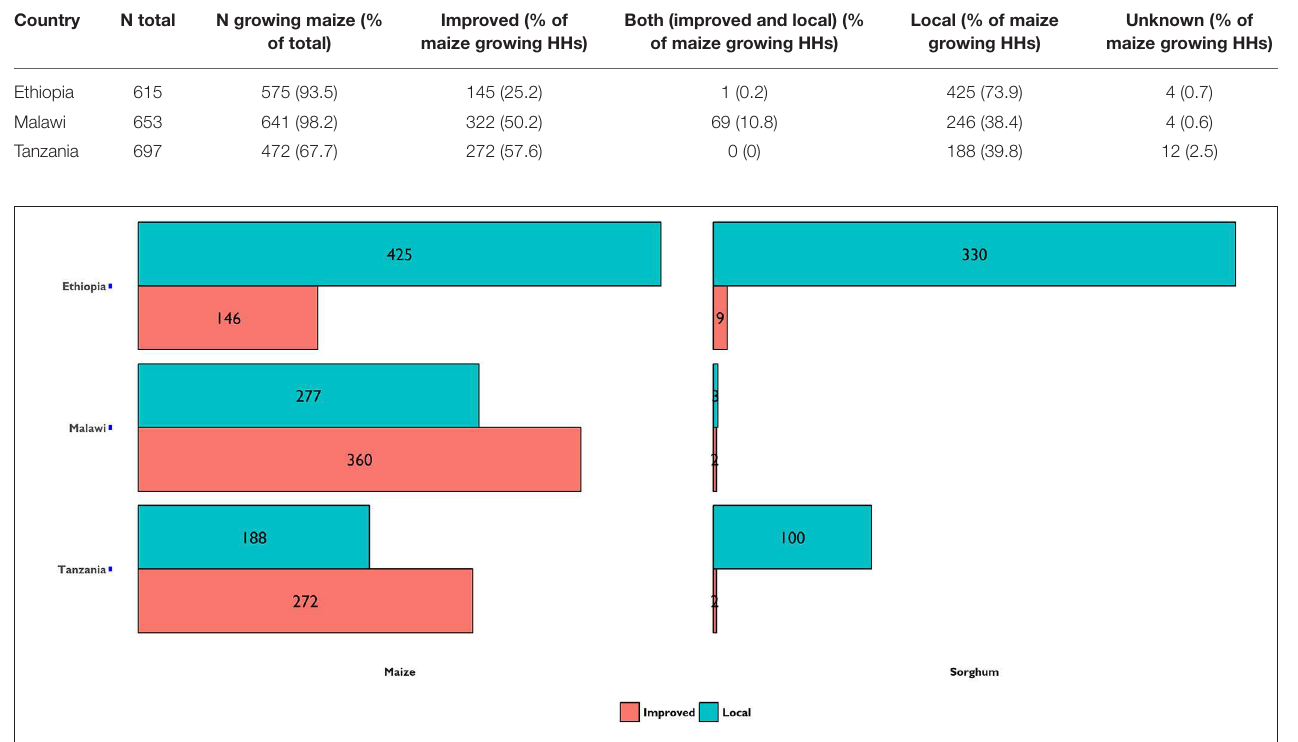
TABLE 2 | Maize cultivation and variety type in the study sites in Ethiopia, Malawi and Tanzania ( N = 1,965 Households). Country